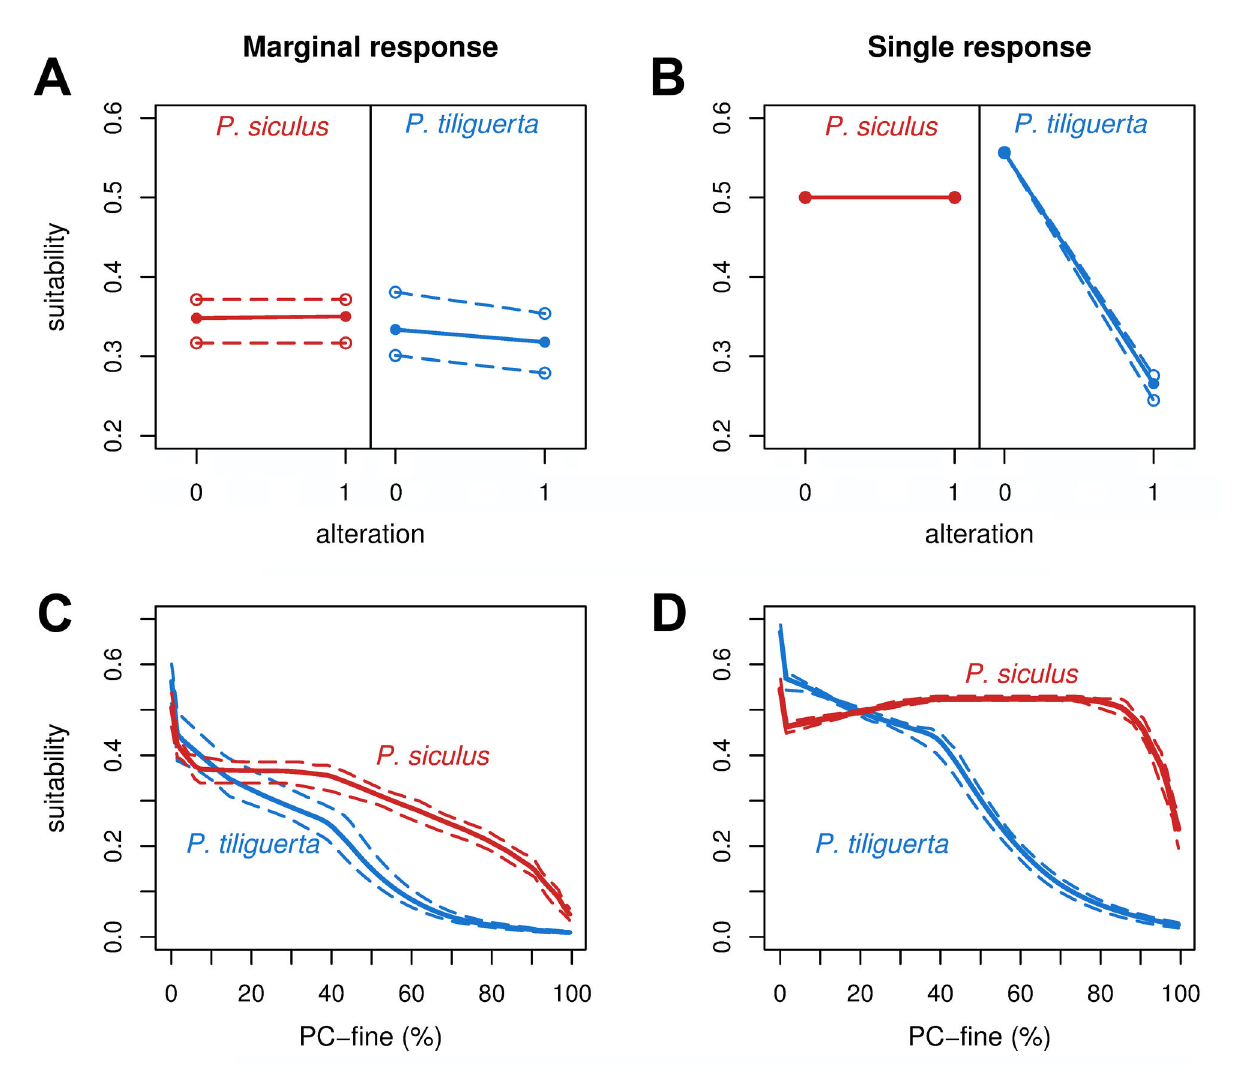
Figure 4. Response curve for the anthropogenic variable of the best model (H ). A: marginal response curves for the variable 2 “alteration” (suitability is obtained from the full model keeping constant all the variables but alteration). B: single variable response curves for the same variable (suitability is obtained from a model including only the variable “alteration”). C: marginal response curves for PC-fine (patch context alteration). D: single variable response curves for the same variable. Solid lines indicate the mean of ten cross validated models; dashed lines represent the minimum and maximum range of the response